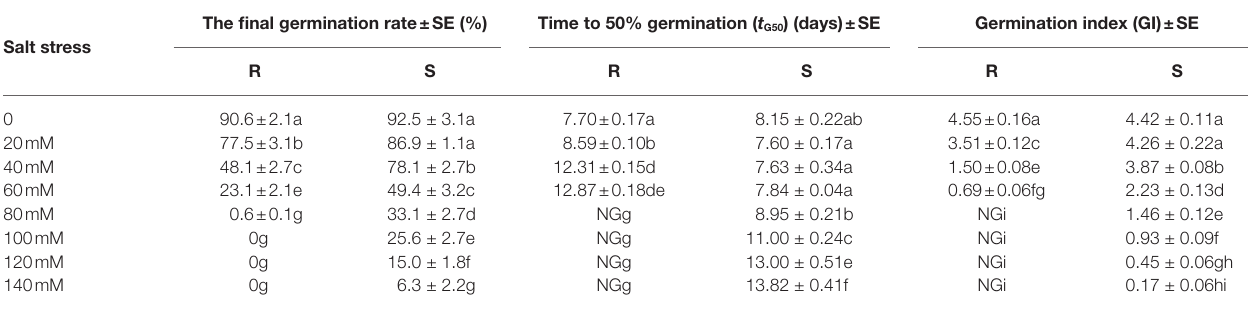
TABLE 1 | Effect of salt stress on the final germination rate, time to 50% germination ( t G50 ), and germination index (GI) of Polypogon fugax . The final germination rate ± SE (%) Time to 50% germination ( t G50 ) (days) ± SE Salt stress